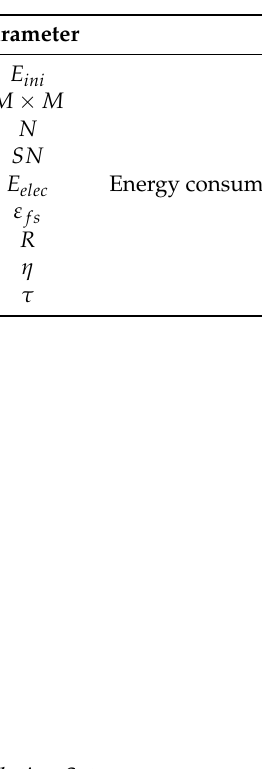
Table 2. Parameters in the model.